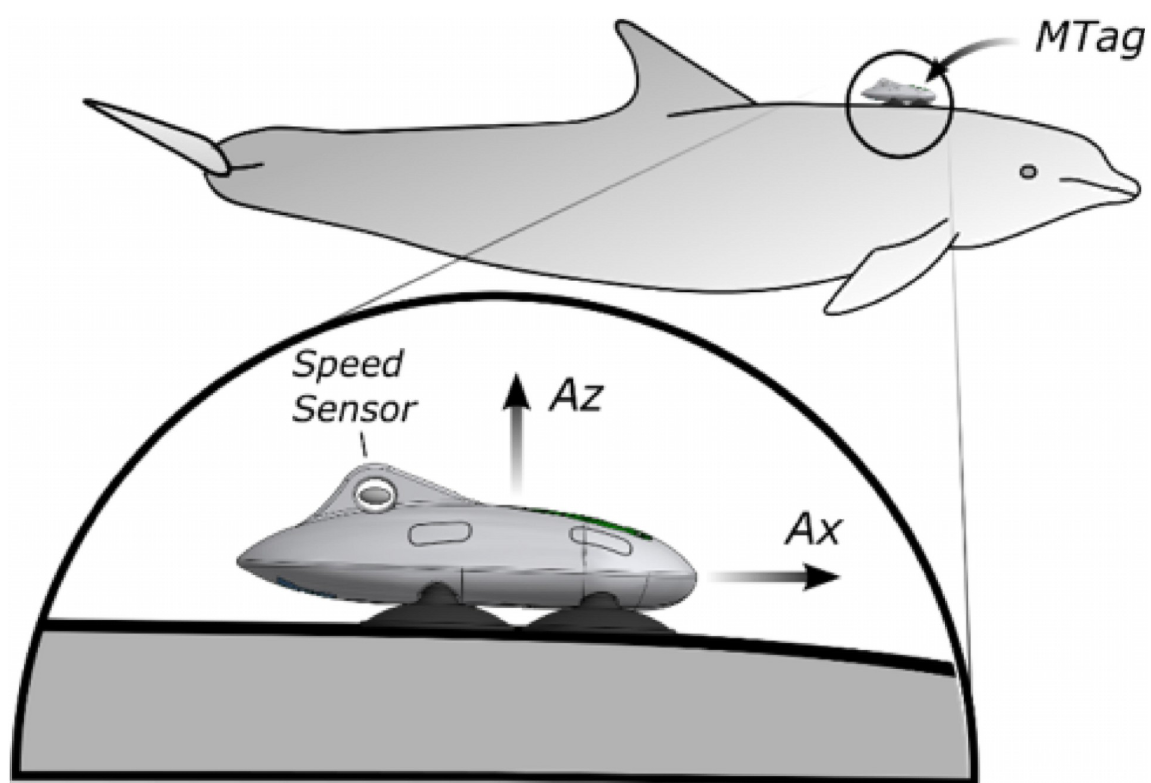
Fig 2. An illustration of the MTag. Speed through the water was measured with an externally mounted speed sensor, and acceleration was measured with an internal 3-axis